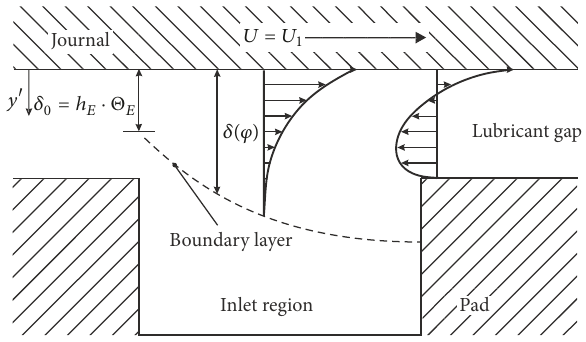
Figure 8: Flow profile in inlet and leading edge pad region.